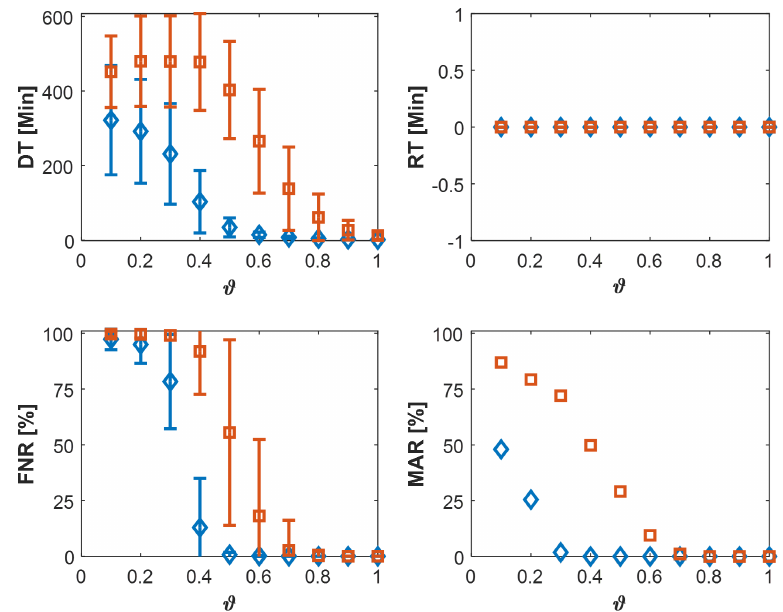
Figure 10. Variation in performance indices of direct method ( (cid:3) ) and PCA method ( ♦ ) with anomaly magnitude for